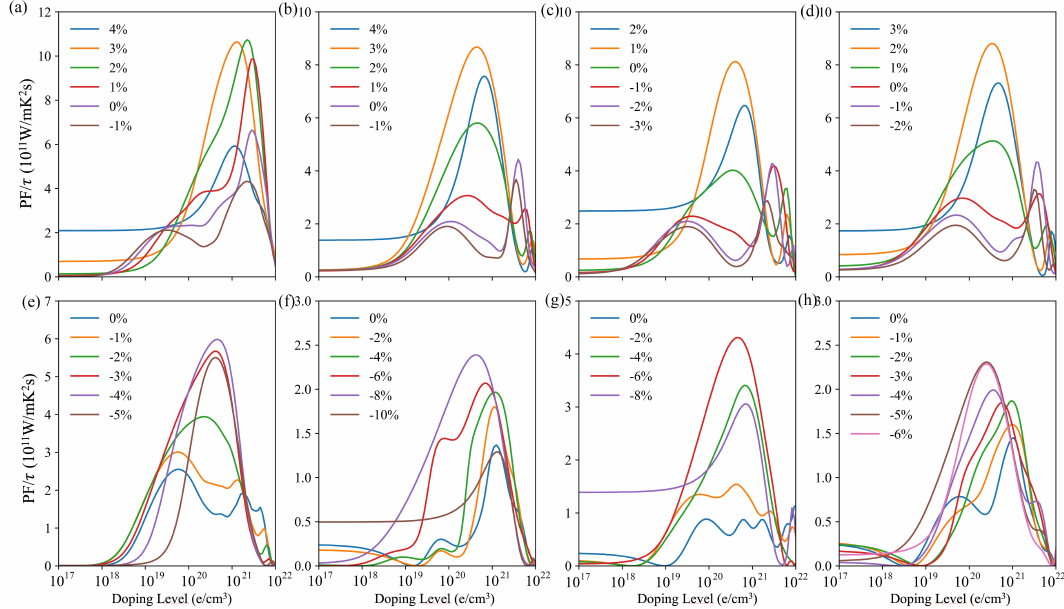
Figure 8. τ -scaled power factor of Bi 2 Te 3 ( a , e ), PbBi 2 Te 4 ( b , f ), PbBi 4 Te 7 ( c , g ) and Pb 2 Bi 2 Te 5 ( d , h ) vs. carrier concentrations for various compressive and tensile strains. Top figures correspond to p -type doping and bottom figures to n -type